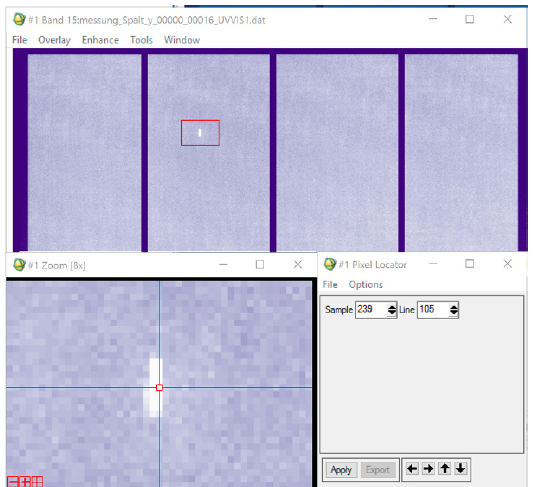
Figure 7. Signal distribution over the UVVISI detector with slit in vertical direction Figure 10. Spectral PSF: In horizontal or spatial direction (upper image) and in vertical or spectral direction (lower image).